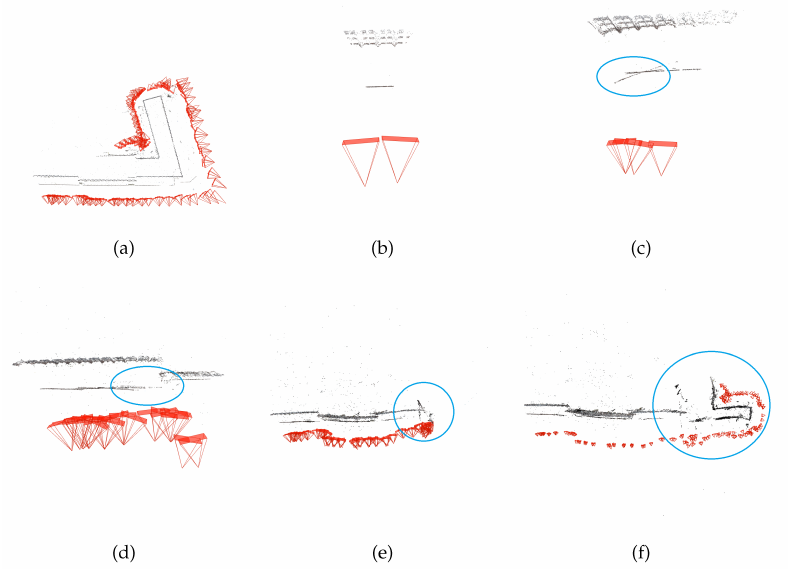
Figure 4. Example of very short baselines: ( a ) the reference reconstruction result; ( b ) initial two-view reconstruction; ( c – f ) reconstruction results as the block grows, where blue ellipses indicate areas where 3D points are incorrectly